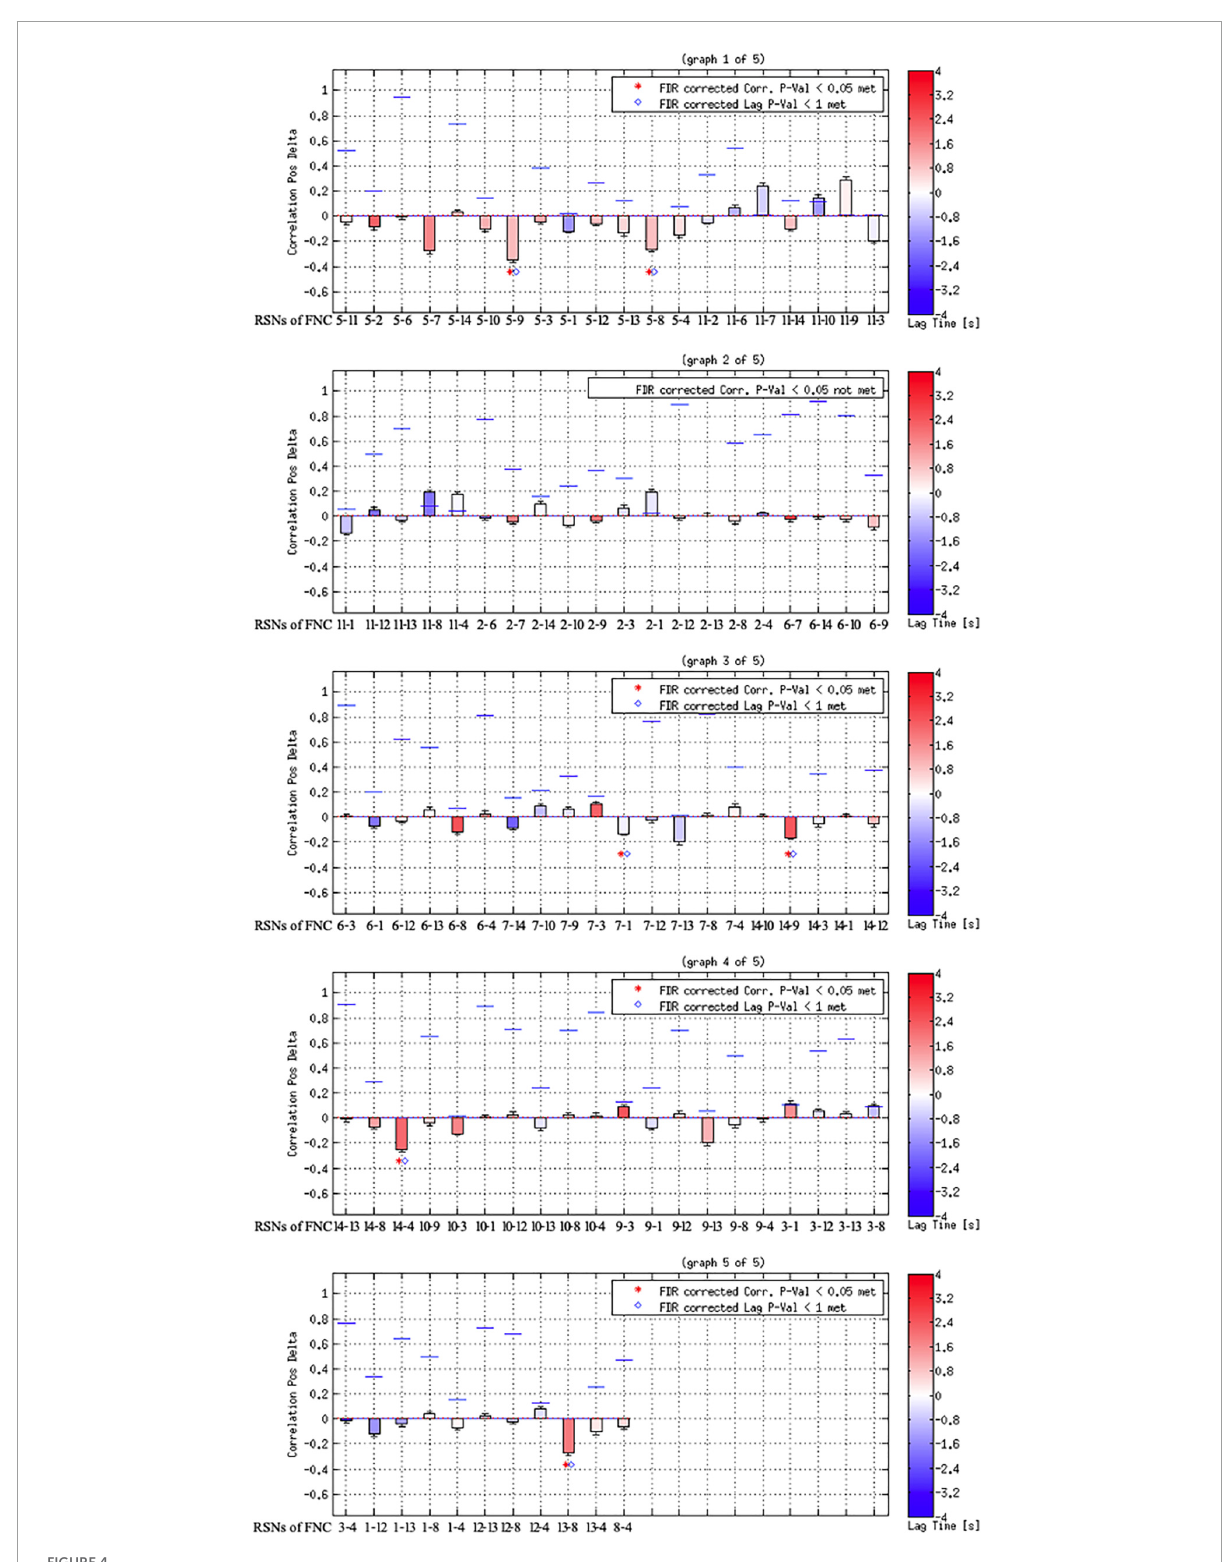
FIGURE4 Results of component combination between each pair of the identified RSNs. The blue lines show the correlation of p -value; the red dotted line shows the user p -value threshold.